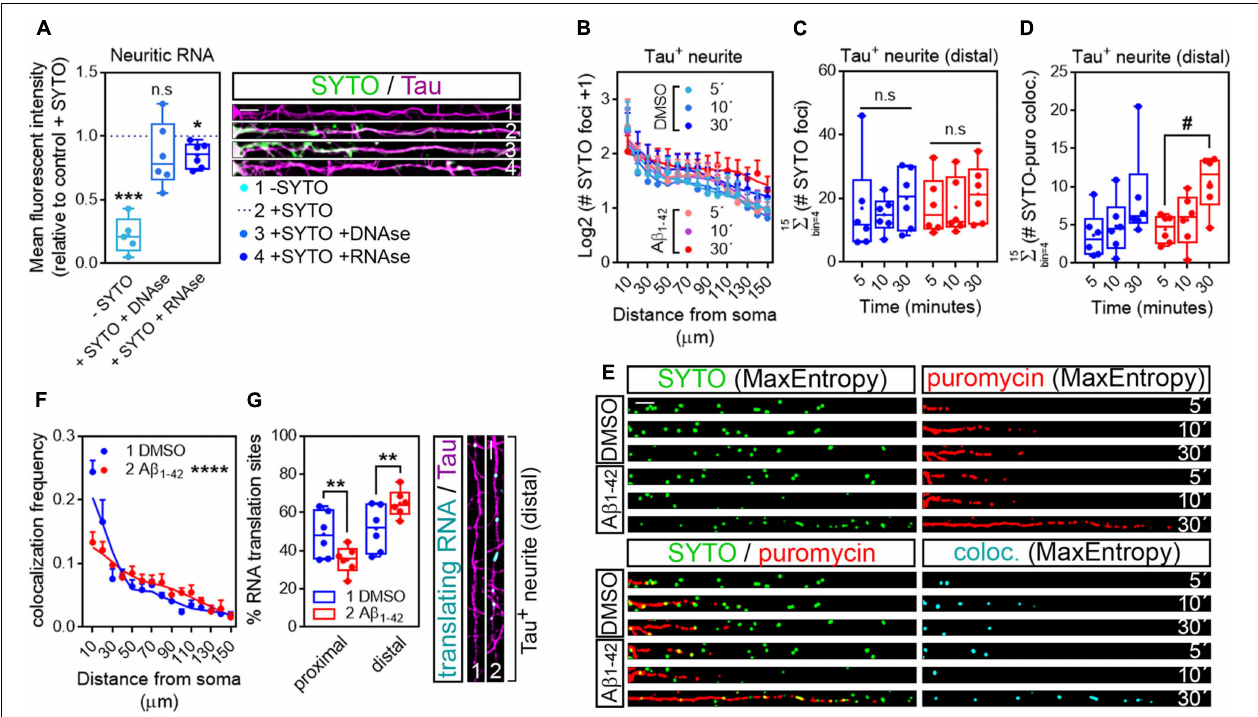
FIGURE 5 | Puromycin-positive foci in axons are a result of local protein synthesis. (A) Cells grown for 9 DIV and treated with DMSO for 24 h. Cells immunostained with an anti-Tau antibody (magenta) were incubated with SYTO RNASelect green fluorescent dye to label endogenous RNA (green). Total green fluorescence intensity was measured in neurites covering a distance of 150 µ m from the edge of the soma (2, + SYTO). As negative control, green fluorescence was measured in cells that had not been incubated with SYTO (1, − SYTO). To determine if SYTO selectively labeled RNA, some fixed cells were digested with DNAse (3, + SYTO + DNAse) or with RNAse (4, + SYTO + RNAse). Box and whisker graphs represent the average relative fluorescence intensity of 10 neurites per condition, shown as individual data points, and the mean and median of 5 ( n = 5, − SYTO negative samples compared to their corresponding + SYTO controls) or 6 ( n = 6, + SYTO + DNAse and + SYTO + RNAse compared to their corresponding + SYTO controls) independent experiments. *** p < 0.001; * p < 0.05; n.s, not significant; two-tailed t -tests. Scale bar, 10 µ m. (B) SYTO-positive staining [as represented in green in (E) ] from randomly selected cells was filtered with the convolver, brightness and contrast were adjusted. Images were converted to 8-bit and binarized with the MaxEntropy mask. The longest Tau-positive neurite was selected with a segmented line and straighten, smoothen and binarized with the MaxEntropy mask (MaxEntropy). SYTO-positive discrete puncta were scored with the particle analyzer in 15 bins covering a distance of 150 µ m from the edge of the soma. The graph shows the average number on puncta represented as Log2 (SYTO foci + 1) vs. distance ± SEM measured in 6 independent experiments ( n = 6). No statistical differences were detected between DMSO- and A β -treated cells incubated with puromycin for 5, 10, or 30 mins. (C) Box and whisker graphs show the total number of RNA granules in distal sites of Tau-positive neurites [ Σ (# SYTO foci)] from DMSO- and A β -treated cells incubated with puromycin for 5, 10, or 30 mins. Data represent the average value of 10 sampled cells per condition plotted as individual data points, and the mean and median of 6 independent experiments ( n = 6). n.s, no significant; two-way ANOVA followed by Tukey’s multiple comparison test. (D) Parallel to processing SYTO-labeled images, puromycin staining was filtered with the convolver, brightness and contrast were adjusted. Images were converted to 8-bit and binarized with the MaxEntropy mask. Same Tau-positive neurites selected for SYTO quantification (green channel) were selected in the red channel [puromycin staining in (E) ], straighten, smoothen and binarized with the MaxEntropy mask. Co-localized objects were obtained with the AND function in the image calculator [cyan in (E) ] and scored in distal sites of Tau-positive neurites with the particle analyzer. Box and whisker graphs show the total RNA-protein colocalized puncta in DMSO- and A β -treated cells incubated with puromycin for 5, 10, or 30 mins [ Σ (# SYTO-puro coloc.)]. Data represent the average value of 10 sampled neurites per condition plotted as individual data points, and the mean and median of 6 independent experiments ( n = 6). # p < 0.05 5 vs. 30 min puromycin in A β -treated cells; two-way ANOVA followed by Tukey’s multiple comparison test. (E) Micrographs from straighten, binarized neurites stained with SYTO RNASelect green fluorescent dye to label RNA (green), with an anti-puromycin antibody to label protein (red) and the resulting images when merging both channels (green, red, and yellow) and when combining both with the AND function in the image calculator (cyan). Cells treated with puromycin for 5, 10, or 30 mins are shown. Scale bar, 10 µ m. (F) The graph represents the frequency distribution of SYTO- and puromycin-positive objects (colocalization frequency) in DMSO- and A β -treated neurites following 30-min puromycin exposure. Colocalized objects were measured with the particle analyzer in 15 bins covering a distance of 150 µ m from the edge of the cell body. **** p < 0.0001 (interaction); two-way ANOVA. (G) Box and whisker graph representing the proportion of colocalized objects (% RNA translation sites) in proximal (0–30 µ m) and distal (last 120 µ m) sites of Tau-positive neurites. Data represent the average value of 10 sampled cells per condition shown as individual data points, and the mean and median of 6 independent experiments ( n = 6). ** p < 0.01; two-tailed t -test. Micrographs show colocalized objects (translating RNAs, cyan) detected within the last 120 µ m (distal) of Tau positive neurites (magenta). Scale bar, 10 µ m.